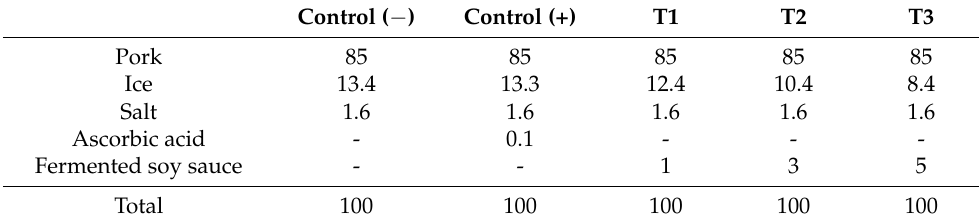
Table 1. Formulation of pork patties with fermented soy sauce